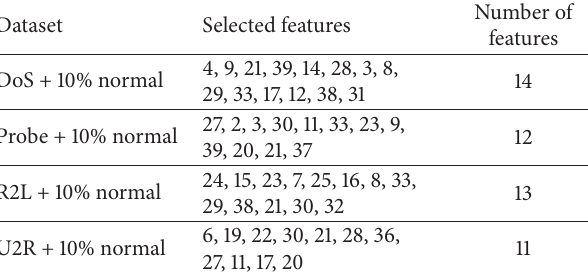
Table 6: List of features selected using RFSM